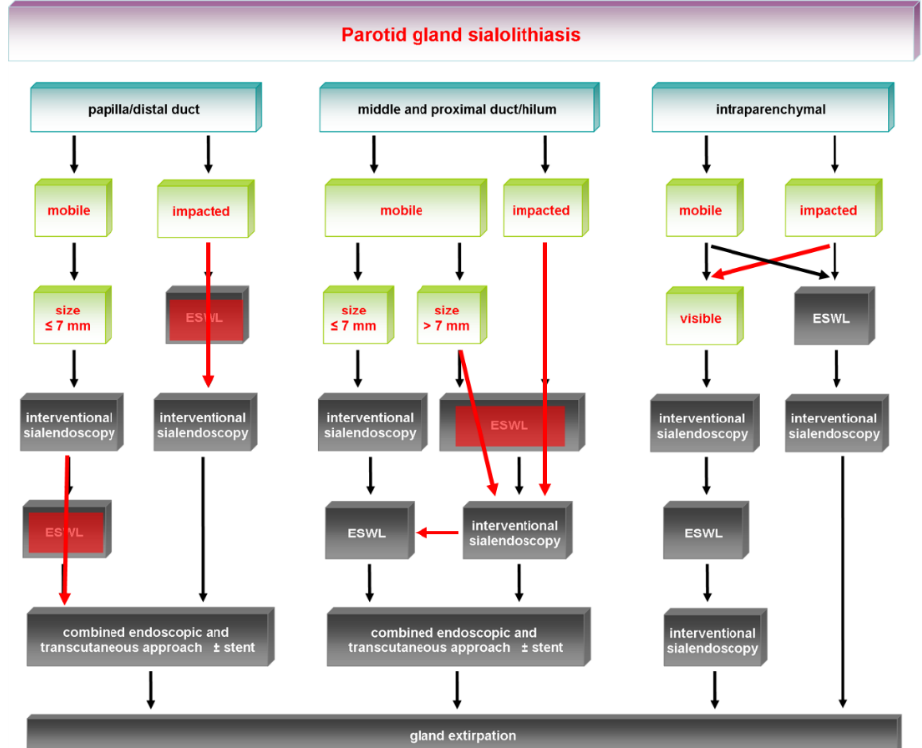
Figure 3. Parotid gland sialolithiasis: earlier treatment algorithms [26], with changes indicated (red-marked boxes, red arrows). ESWL, extracorporeal shock-wave lithotripsy.